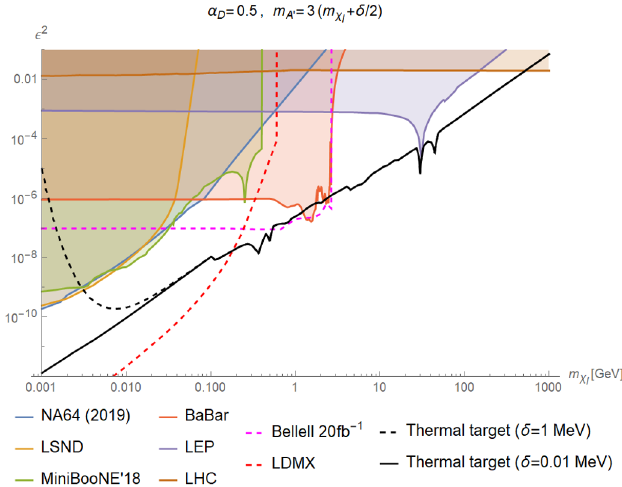
Figure 6 . Constraints from accelerator-based searches on the kinetic mixing parameter (cid:15) 2 for + δ/ 2) and α = 0 . 5 . Solid color lines correspond to current bounds and dashed color m A 0 = 3 ( m χ D l lines to prospective bounds. The black lines denote the (cid:15) 2 value needed to get the observed dark matter abundance assuming χ and χ constitute all dark matter. For δ . m l h required to obtain the observed thermal relic is large; this leads to a large (cid:15) 2 value which has already been ruled out. Analogous plots for additional dark-sector benchmarks are shown in figure